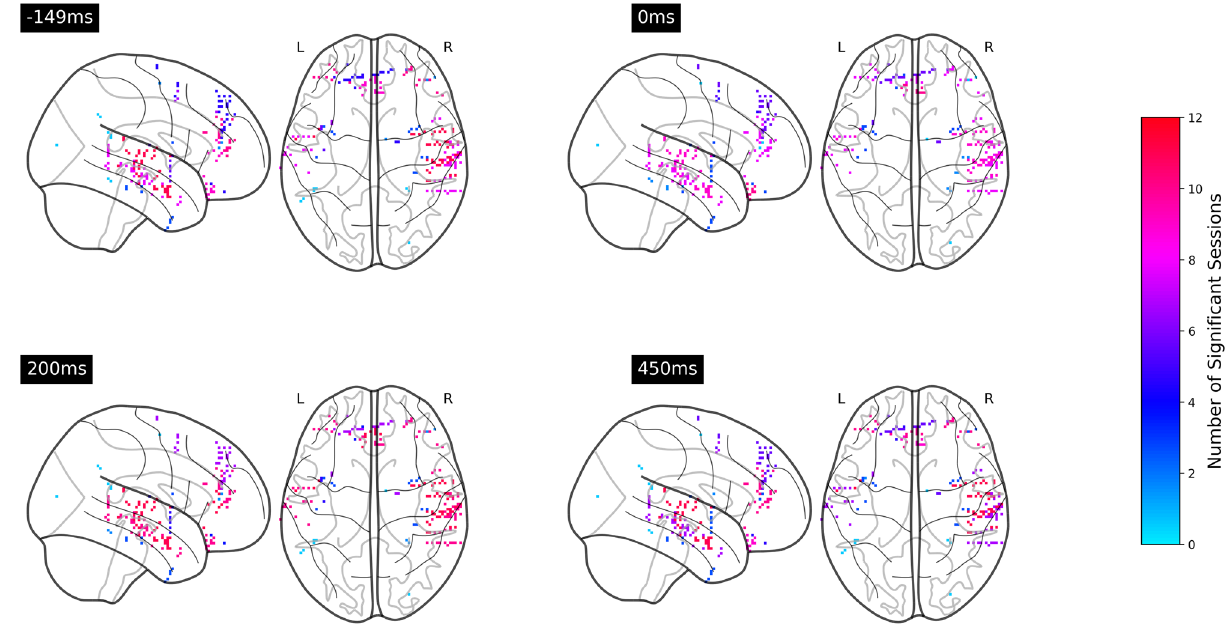
Figure 7. Number of significant sessions within each cortex at − 149 , 0, 200, 450 ms relative to phrase boundaries .